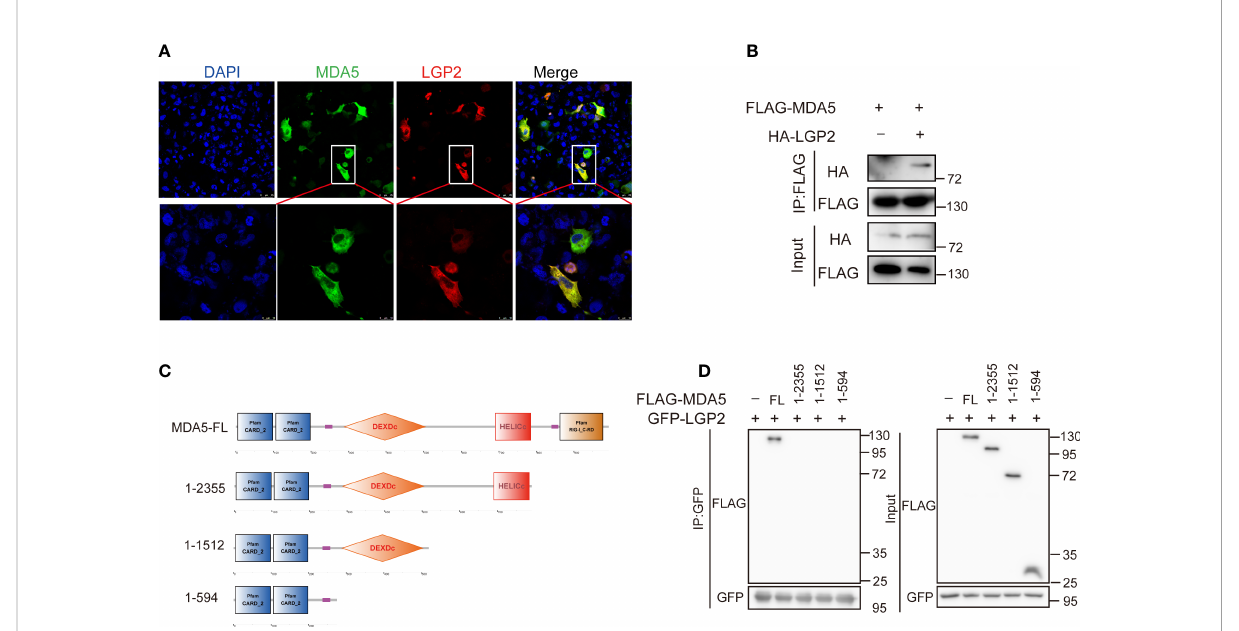
FIGURE 7 Cc LGP2 protein interacts with Cc MDA5 through the RD domain. (A) EPC cells were transfected for 24 h with plasmids expressing GFP-tagged Cc MDA5 and mCherry-tagged Cc LGP2. After staining with DAPI, the coverslip was observed under a laser scanning confocal microscope. (B) As indicated in the fi gure, FLAG-tagged Cc MDA5 and HA-tagged Cc LGP2 were separately transfected into 293T cells. The cell lysates were immunoprecipitated with anti-FLAG antibodies and further immunoblotted with anti-FLAG and anti-HA antibodies. The control group was transfected with FLAG-tagged Cc MDA5 and empty vector pCMV-HA. (C) Schematic diagram of full-length and mutant CcMDA5. (D) GFP- tagged Cc LGP2 and different truncations of Cc MDA5 were transfected into 293T cells for 48 h as indicated in the fi gure. The cell lysates were immunoprecipitated with anti-GFP antibodies and further immunoblotted with anti-FLAG and anti-GFP antibodies. All the experiments were repeated at least